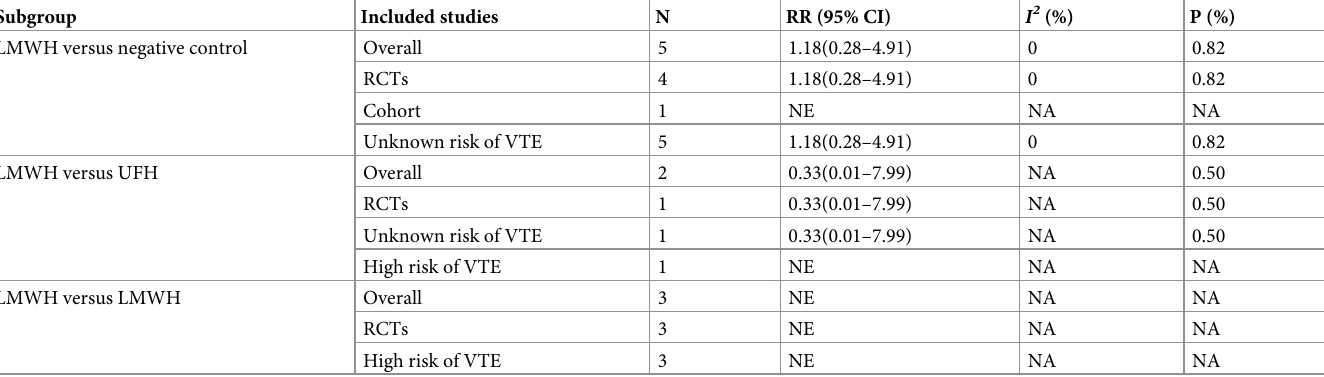
Table 2. Summary of the meta-analysis of thromboprophylaxis efficacy following CS. Subgroup